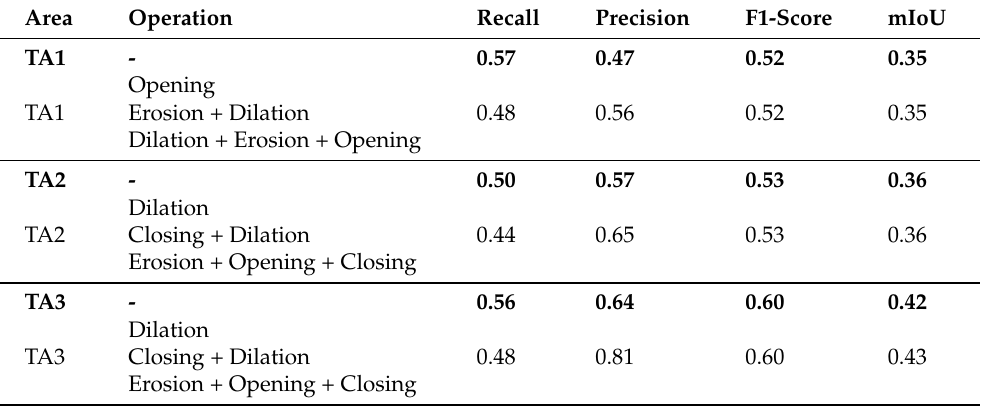
Table 2. Best post-processing operations and results for each test area. The best results were cal- culated by summing all the result values. Values in bold represent the best results before the post-processing